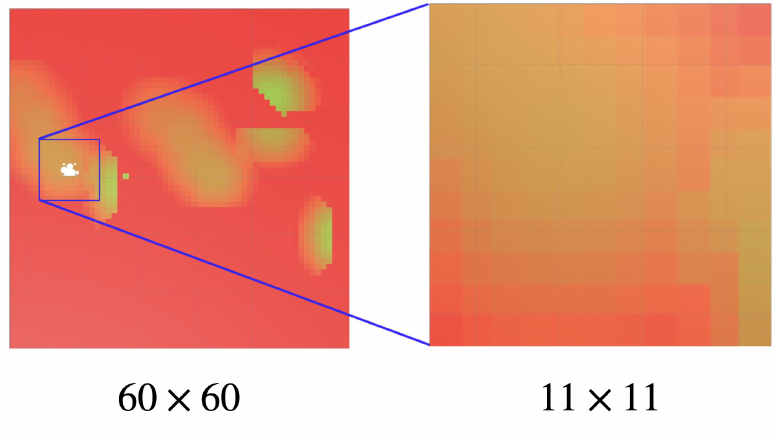
Figure 3. Visual observation of a drone is a 11 × 11 portion of the plotted priority vector P t in its neighbourhood.